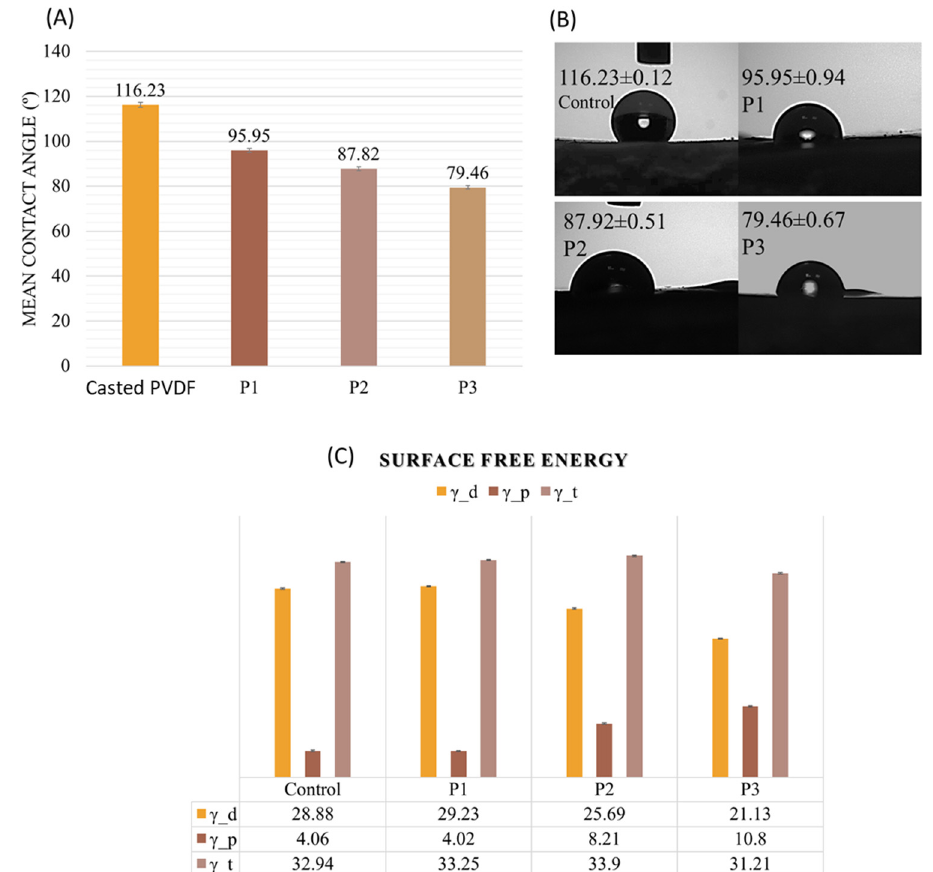
Figure 5. Histogram of contact angles (CA) of PVDF samples ( A ), optical images of the droplets onto surfaces and their corresponding CA ( B ), and the histogram of surface free energy (SFE) of casted and replicated PVDF (microstructured PVDF replicas annealed at 60 °C with different depths: P1 0.8µm, P2 1.5 µm, P3 2.5 µm) ( C ).